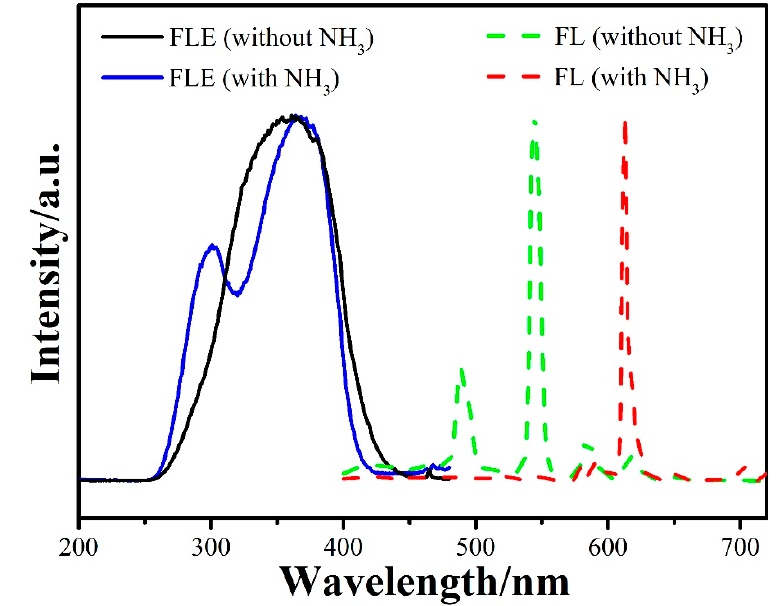
Figure 2. FL excitation (solid line) and FL emission spectra (dot line) of Eu 0.5 Tb 0.5 (HPBA n )@ZY before and after treatment with NH 3 vapor.